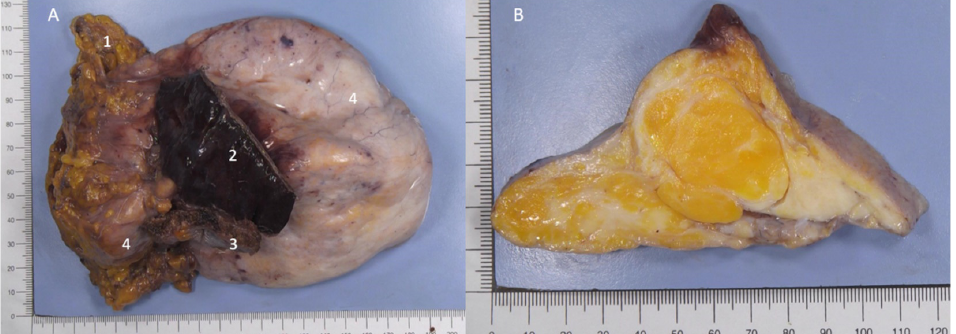
Figure 2. ( A ) Hamartochondroma consisting of a firm, bumpy-contoured, encapsulated mass meas- uring 16.5 × 11 × 5.8 cm and weighing 442g. 1: pericardial fat. 2: lung parenchyma. 3: diaphragm. 4. hamartochondroma. ( B ) After fixation, a yellowish and whitish tumor is observed. There is contact with the right lung, diaphragm and pericardium without invasion.